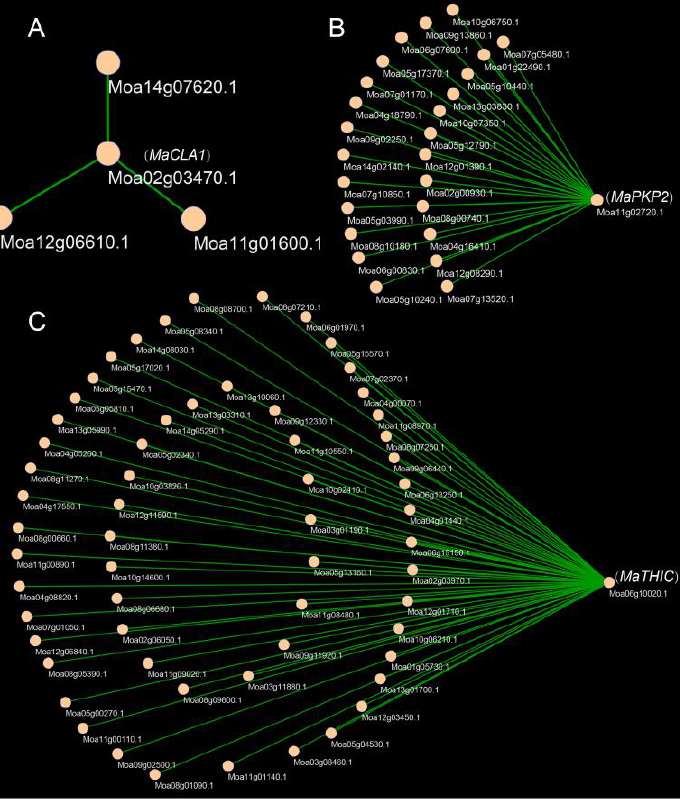
Figure 6. Co-expression genes of MaCLA1 , MaPKP2 , and MaTHIC . ( A ) Co-expression genes of MaCLA1 ; ( B ) Co-expression genes of MaPKP2 , ( C ) Co-expression genes of MaTHIC .